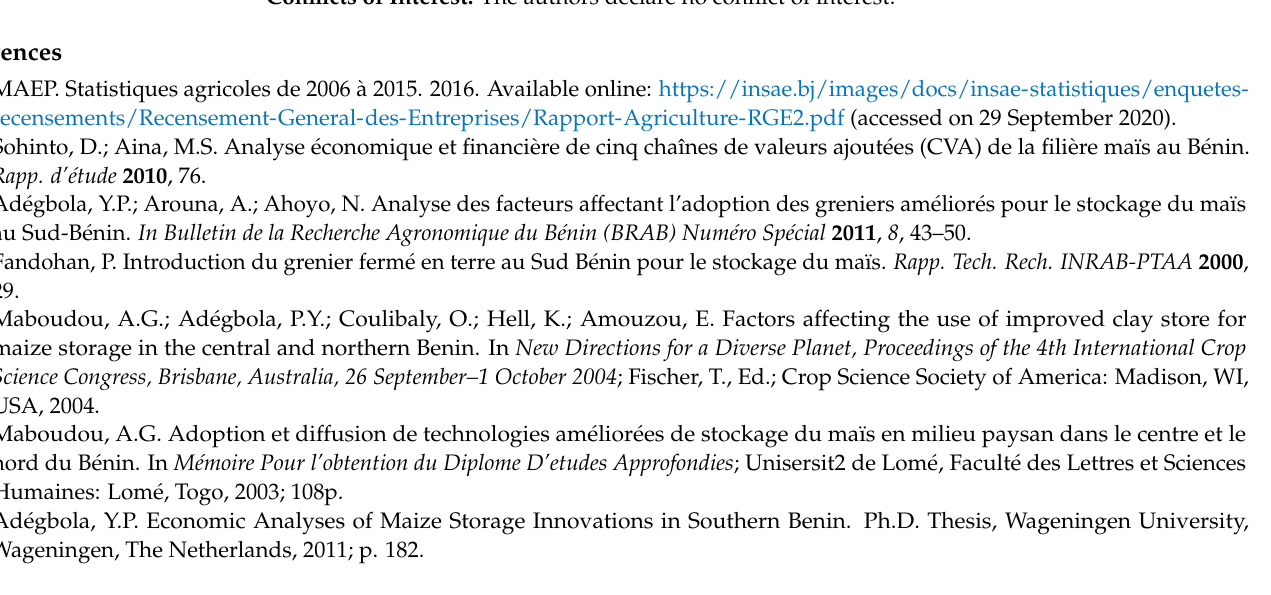
bag, Table S2: Monthly flow costs of storing one kilogram of maize in the PICS bags, Table S3: Monthly flow costs of storing one kilogram of maize in the Metal silo, Table S4: Monthly flow costs of storing one kilogram of maize in the Improved clay